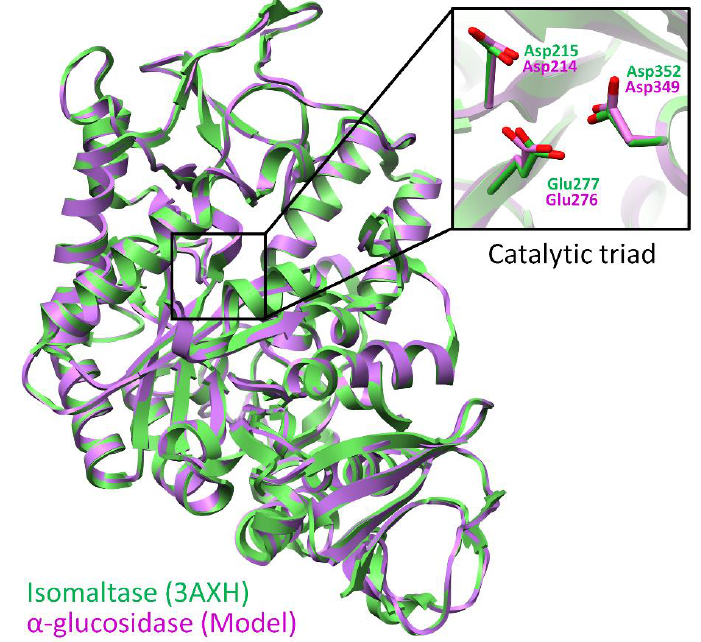
Figure 3. The superimposed view of model (purple ribbons) and template (3AXH in green ribbons) shows the structural topology of the model is similar to its template and residues of catalytic triad is represented in stick representation. Table 3. Comparison of active site residues of template and model